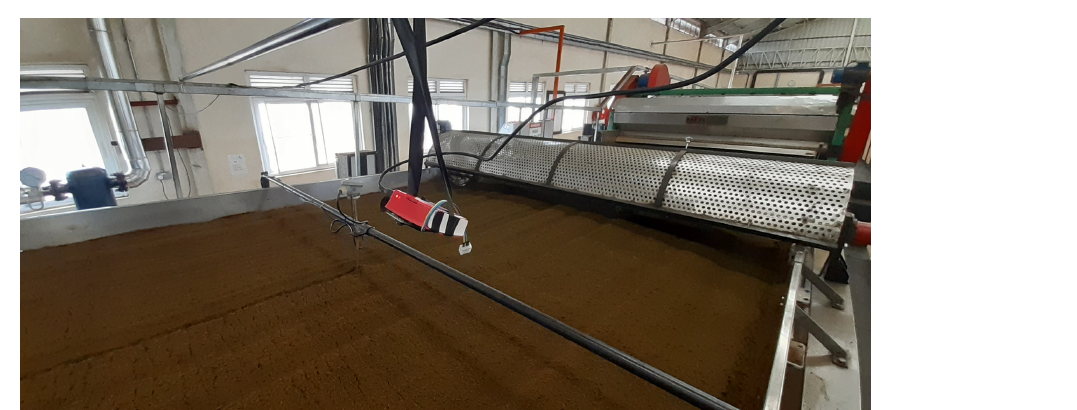
Figure 8. Application of Raspberry Pi 3 Model B + with the Pi camera for taking pictures during the fermentation of black tea in the Sisibo Tea Factory,